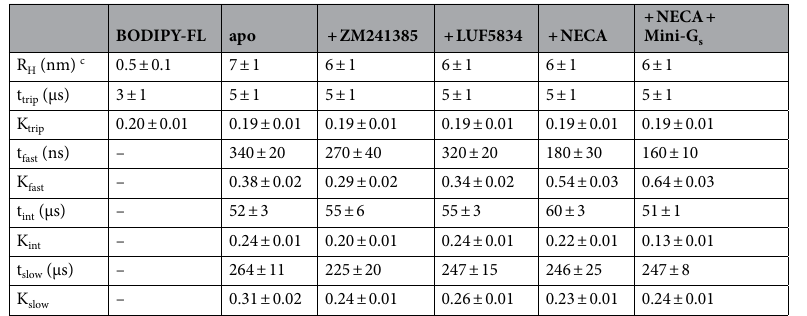
Table 4. FCS fitting parameters for free BODIPY-FL and for BODIPY-FL-labelled A 2A R bound to different ligands. FCS data (Fig. 3 and Fig. S3a) were fitted to Eq. 5. Parametric deviations are the standard deviations obtained from the fit. The hydrodynamic radius, R H , was calculated from the fitted diffusion time using Eq. 6.